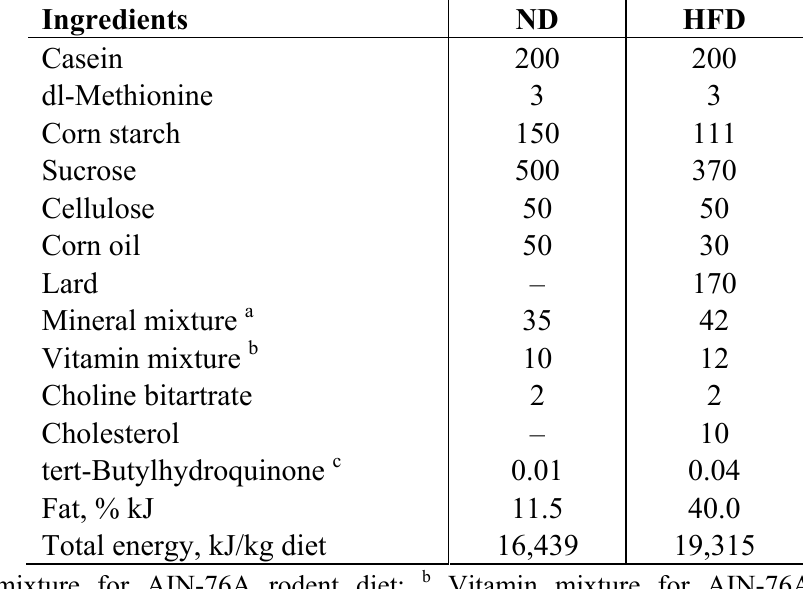
Table 6. Composition of the experimental diets (g/kg) fed to rats